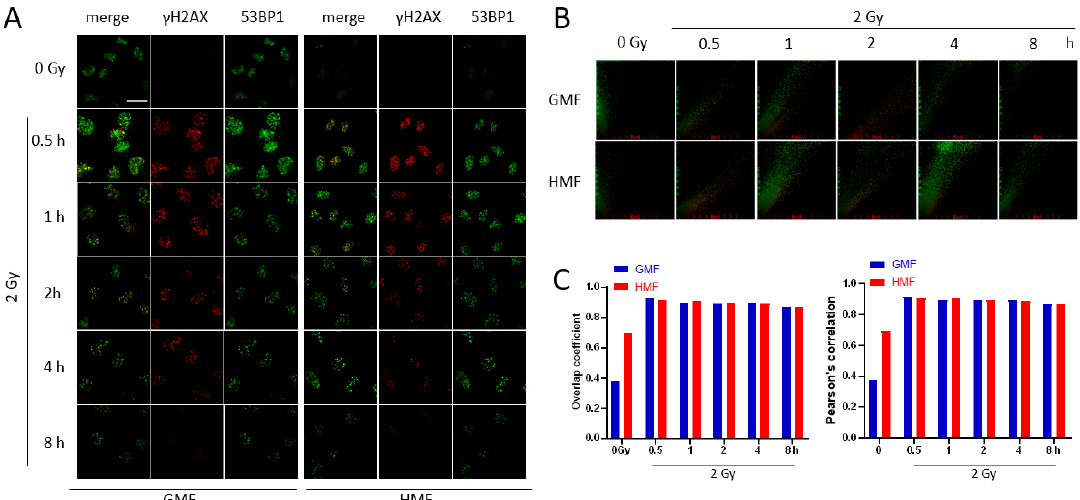
Figure 6. Effects of geomagnetic shielding on IR induced colocalization of γ H2AX and 53BP1. ( A ) Representative images from immunofluorescence staining of colocalization between phospho-histone H2AX and anti-53BP1 antibodies in HMF or GMF cultured BEAS-2B cells that were incubated until indicated time post-irradiation and immunofluorescent staining was performed. Scale bar = 30 μ m. ( B ) 2D correlation histogram of the colocalized γ H2AX and 53BP1. ( C ) Colocalization coefficients of γ H2AX and 53BP1 immunofluorescent staining in BEAS-2B cells cultured with HMF or GMF were incubated until indicated time post-irradiation. Data were analyzed using one-way ANOVA.